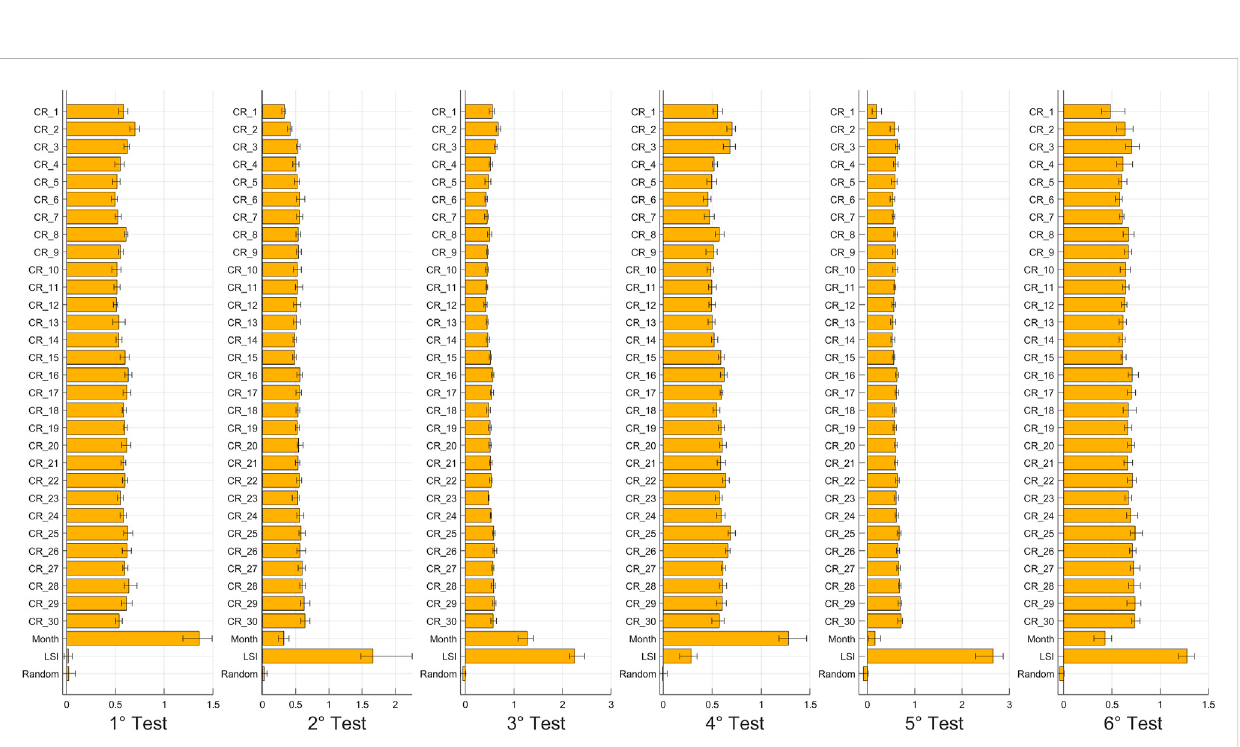
FIGURE 5 Histograms of OOB Permuted Predictions Importance Estimates for the second con fi guration.